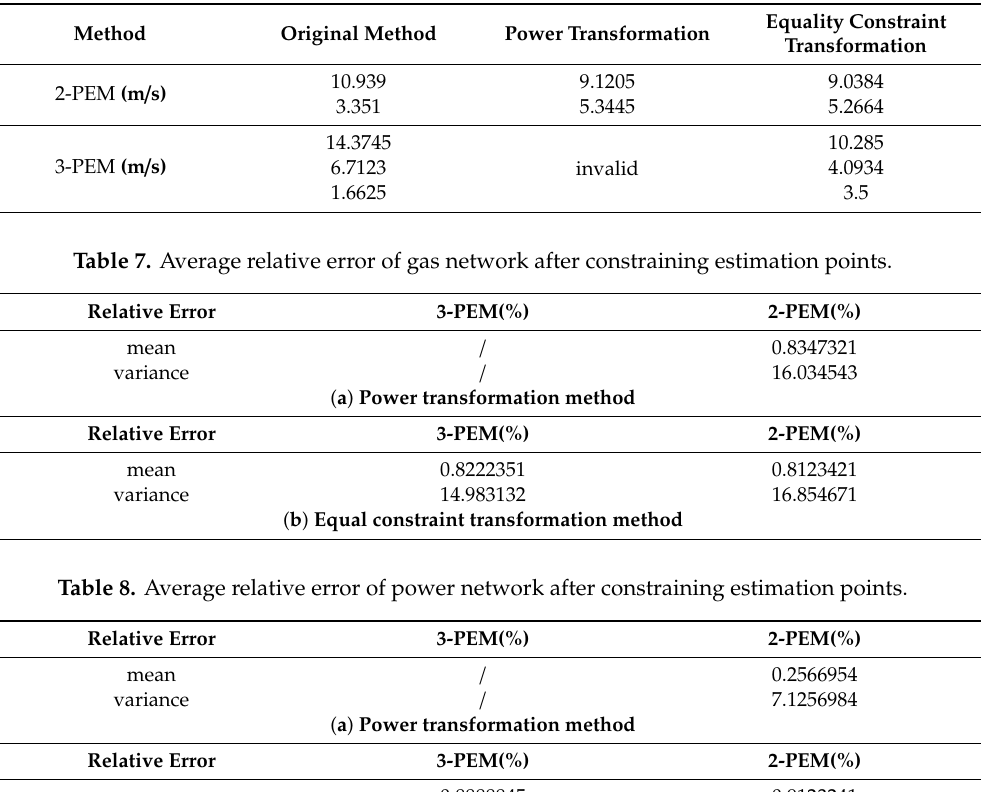
Table 6. Comparison of estimation points for di ff erent methods.